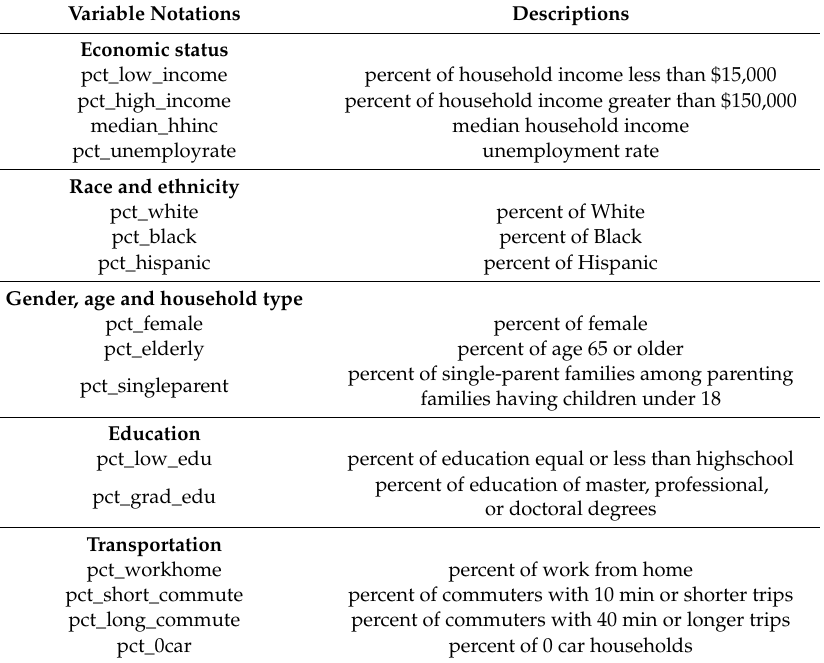
Figure 1. Heat map of home dwell time for 219,972 CBGs in the U.S. from January 1, 2020, to August 31, 2020. High/low concentrations are marked as red/blue. Table 1. Notations and descriptions of the demographic and socioeconomic variables in the selected five major